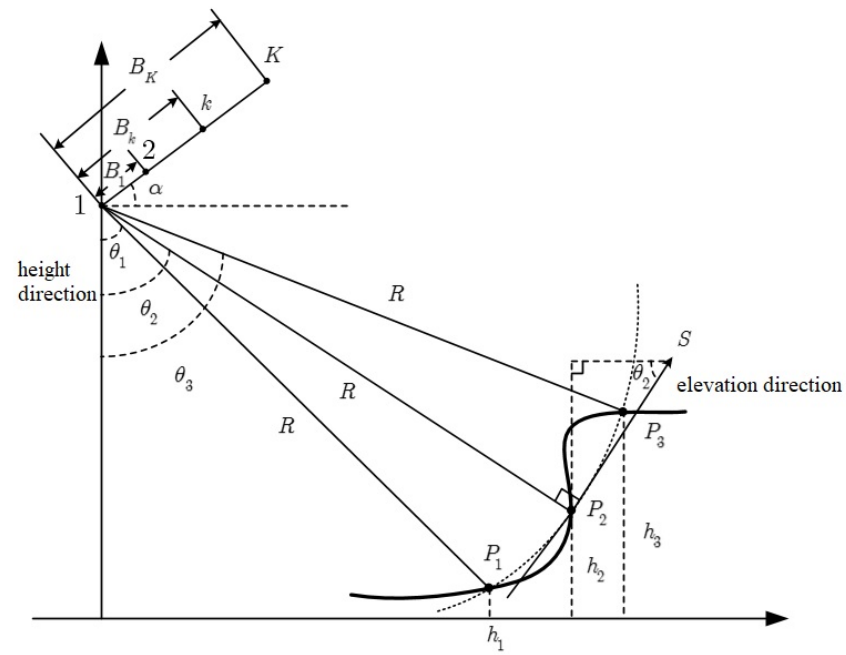
Figure 1. Layover model of multi-baseline SAR.